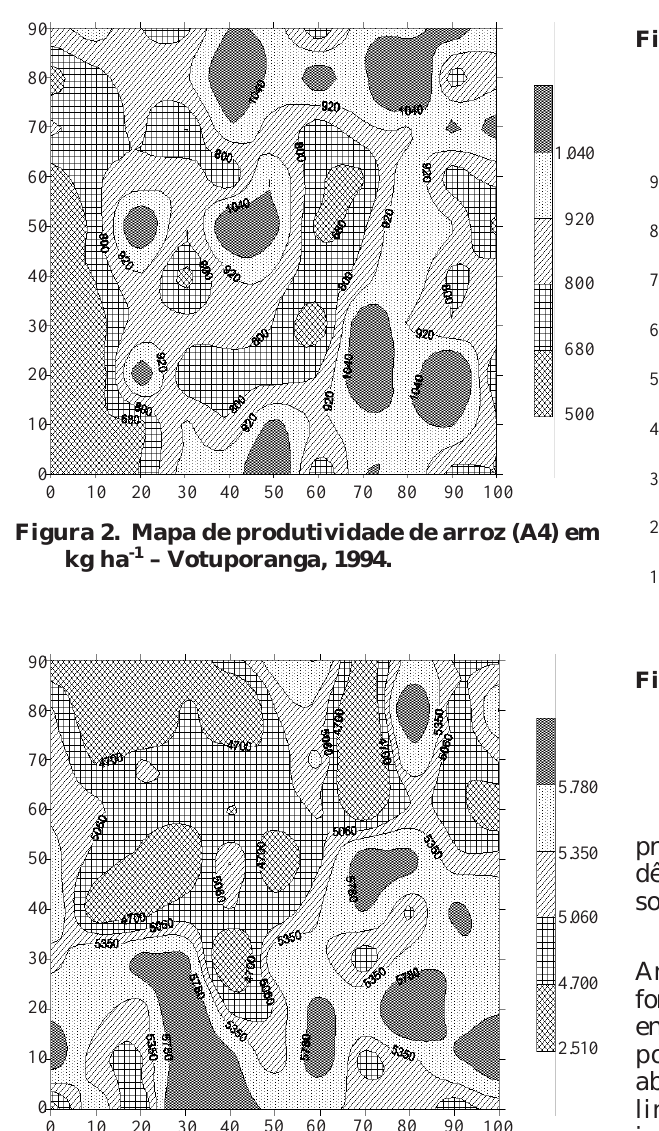
Figura 3. Mapa de produtividade de milho (M5) em kg ha -1 – Votuporanga, 1995.